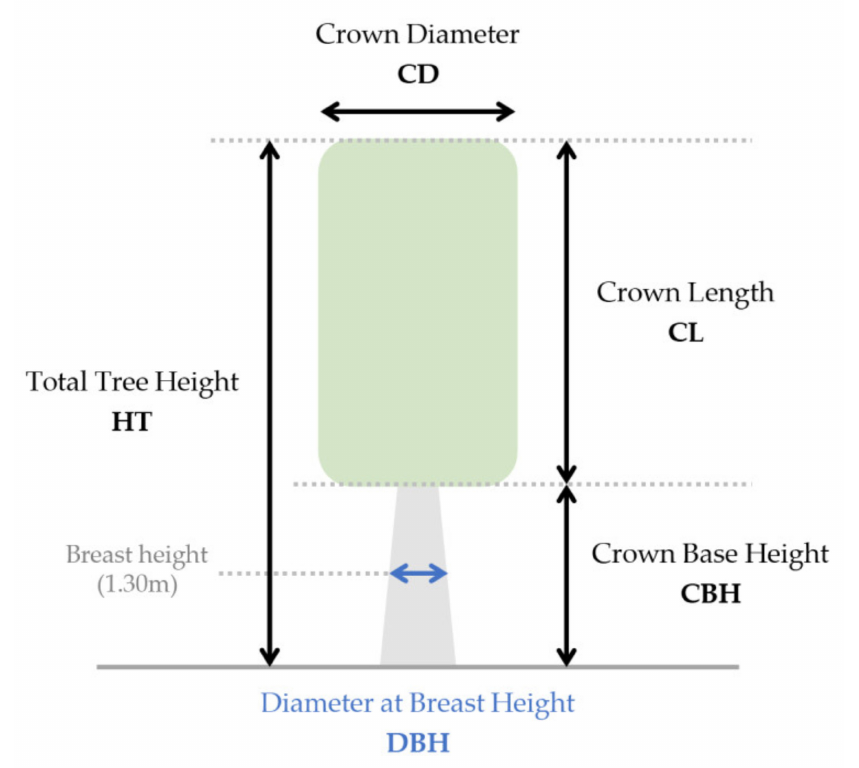
Figure 3. Schematic representation of the geometry of a tree, showing the variables